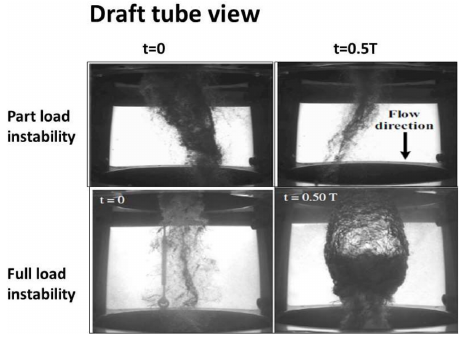
Figure 3. Vortex rope characteristic at the Turbine outlet during the part load and the full load